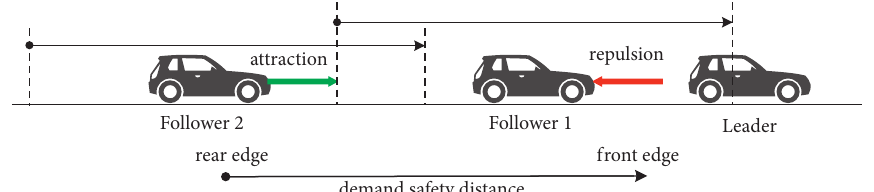
Figure 2: Force status of car-following vehicles.